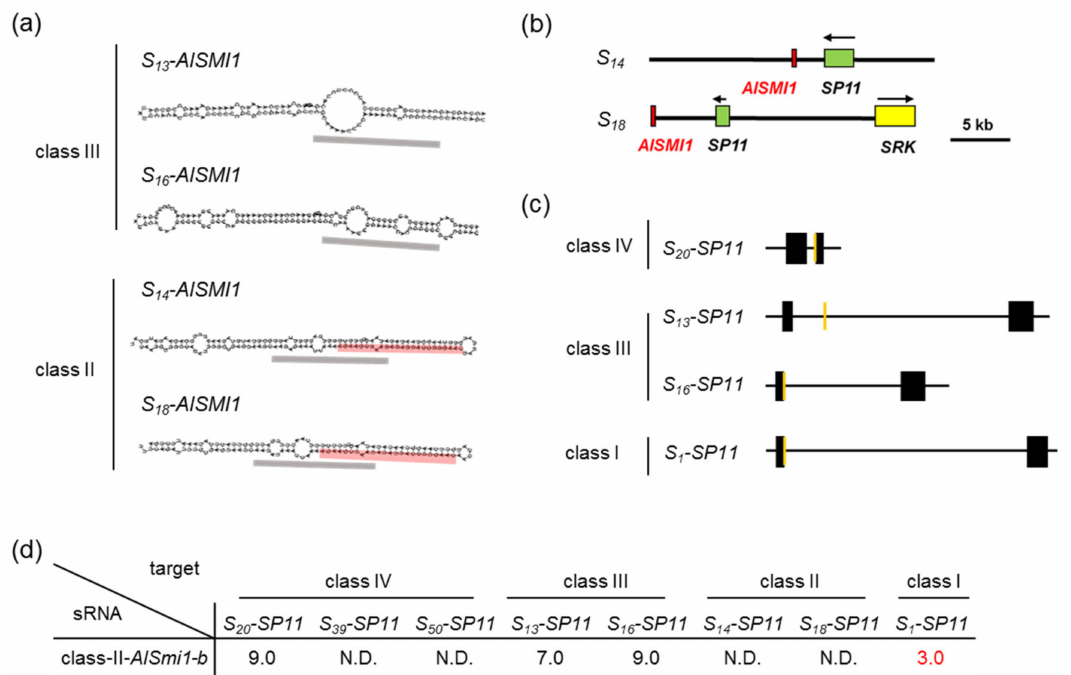
Figure 3. Identification of sRNAs controlling the dominance–recessivity relationships: class II > class I. ( a ) Stem-loop structures of the S 13 , S 16 , S 14 , and S 18 haplotypes of AlSMI1 predicted by RNAfold [20]. Black dashed boxes indicate 24-nt snRNAs corresponding to class-III and class-II AlSmi1-a. The predicted 24-nt mature AlSmi1-b is shown in red. ( b ) Schematic diagrams of the S locus in the S 14 haplotype (KJ772406) and S 18 haplotype (KJ772412). Green, yellow, and red boxes indicate SP11, SRK , and AlSMI1 , respectively. ( c ) Schematic diagrams of the SP11 genomic regions of the S 20 , S 13 , S 16 , and S 1 haplotypes. Black boxes indicate exon regions of SP11, orange boxes indicate the target regions homologous to AlSmi1-b . ( d ) Sequence similarity between AlSmi1-b and SP11 . Numbers are the mispair scores between class-II AlSmi1-b and class-IV, class-III, class-II, and class-I S haplotypes of SP11 . N.D., not detected. Mispair scores < 5.5 are shown in